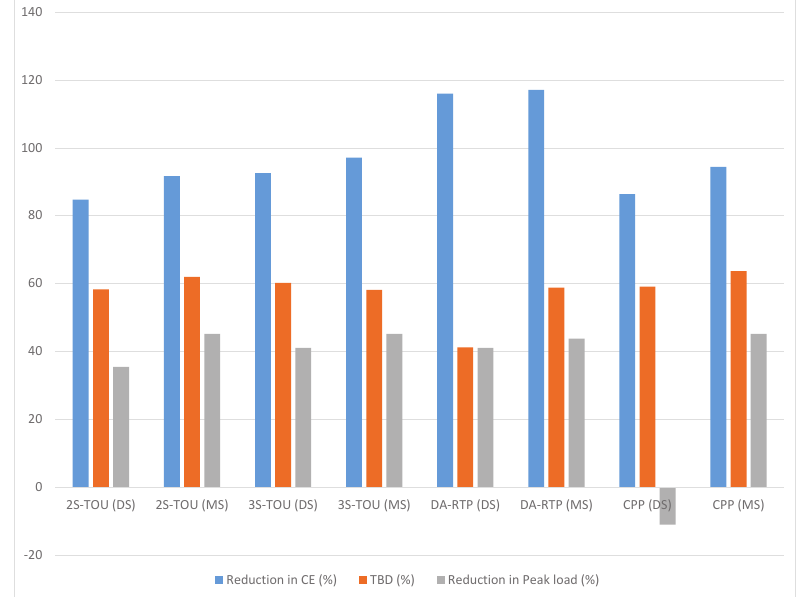
Figure 19. Table 7 furnishes the achieved performance parameters for the maximal reductions in the CEnet , and the corresponding values of TBD and peak load for the complete set of TPs.